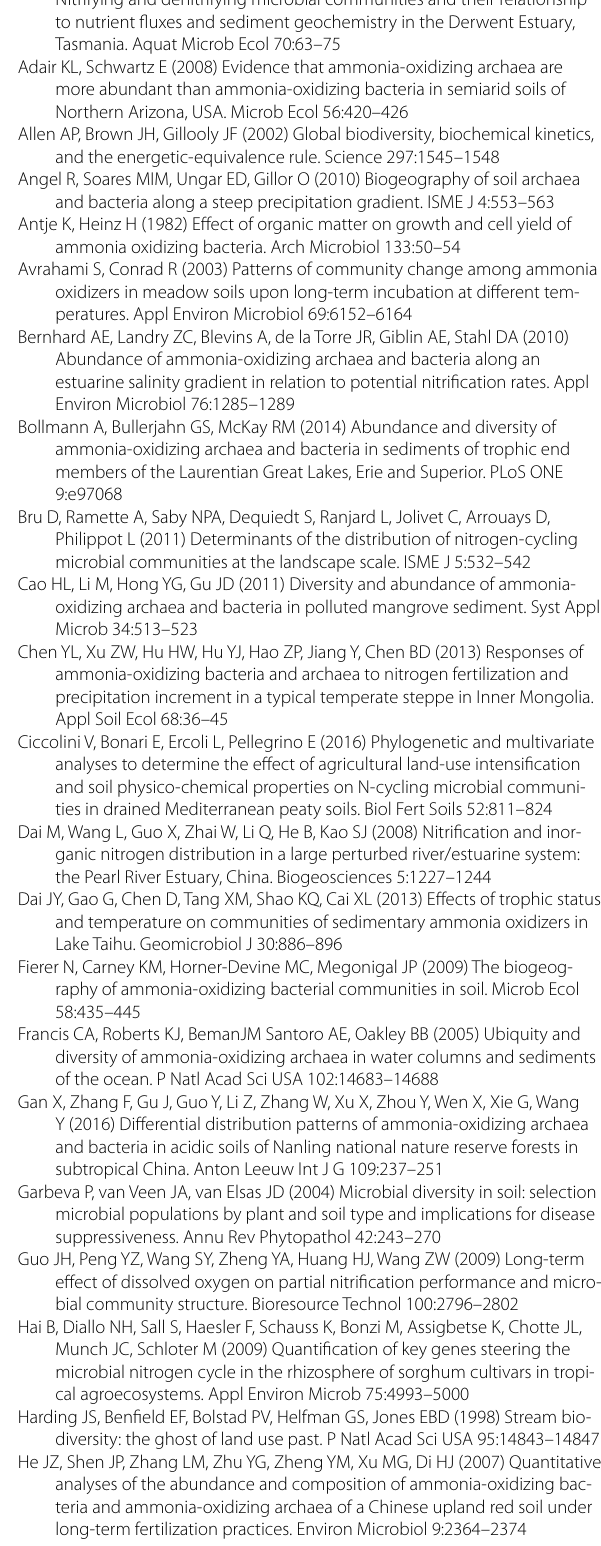
Additional file 1. Figure S1: Rarefaction curves of the amoA gene sequences of AOA obtained from 35 lake sediments. Figure S2 : Rarefac- tion curves of the amoA gene sequences of AOB obtained from 35 lake sediments. Table S1 : Primers and conditions for qualitative and quantita- tive PCR. Table S2 : Abundance and diversity indices of clone libraries of archaeal amoA genes in different sampling sites. Table S3 : Abundance and diversity indices of clone libraries of bacterial amoA genes in different sampling